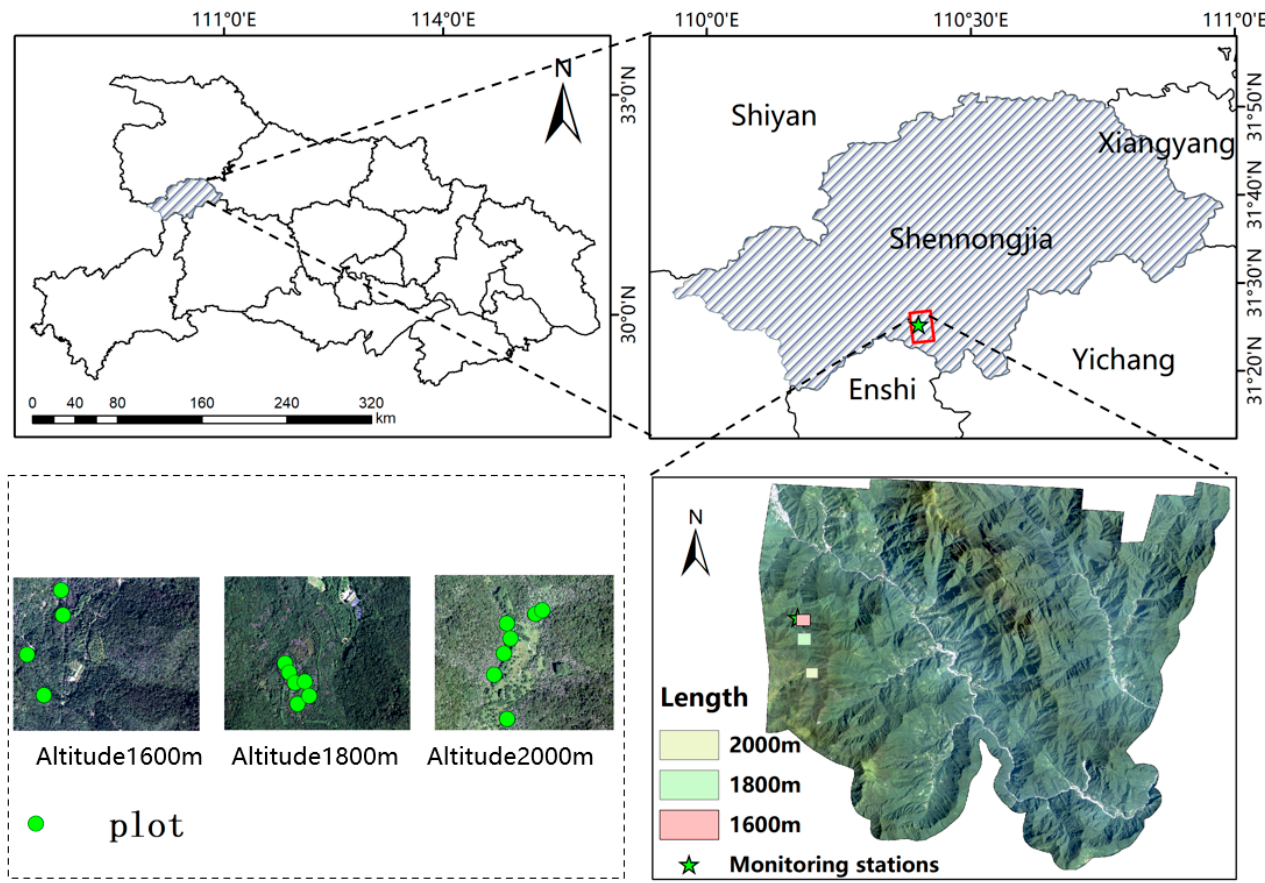
Figure 1. Study area location.